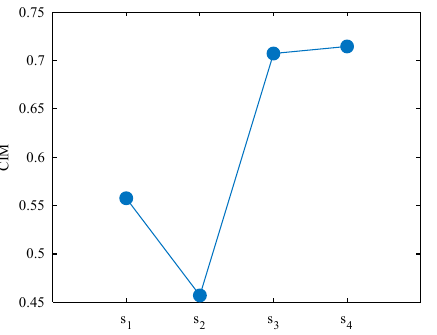
Figure 4. CIM between the first four simulation signals and s 5. The frequency spectrum of s 2 contains the most frequency components of s 5 , so for a method based on frequency component analysis, it is appropriate to choose s 2 with the lowest CIM to represent s 5 . Moreover, the largest value of CIM is produced by s 4 and s 5 , where s 4 is the random noise, which also shows that CIM-based selection can effectively reduce noise interference.